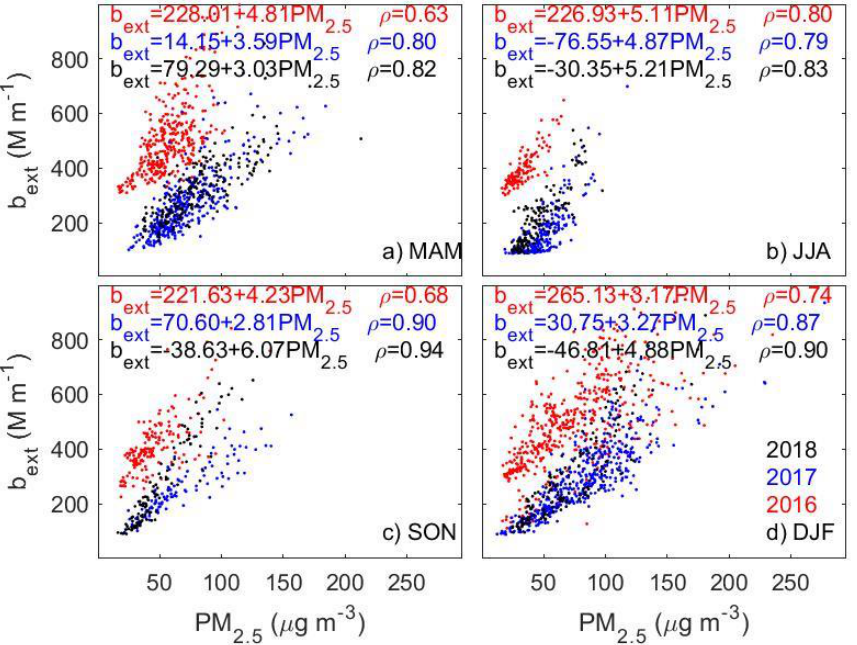
Figure 5. The scatter plot of seasonal matched points of PM 2.5 and b ext in different years at Yangzhou, Jiangsu province.